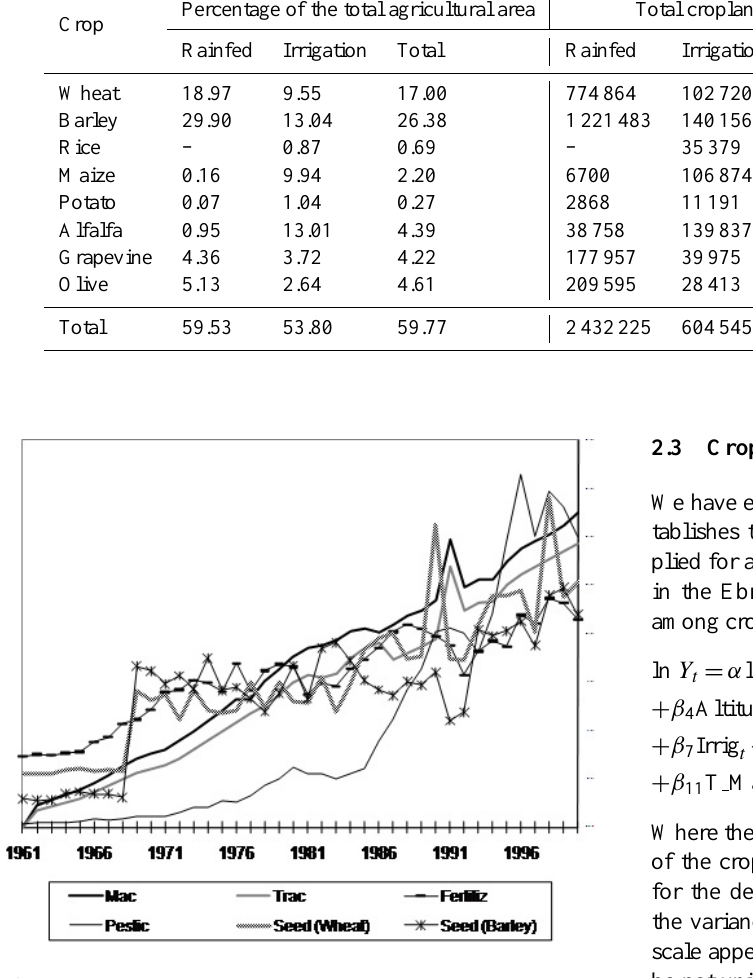
Fig. 2. Evolution of management indicators: farm equipment power (Mac), tractors (Trac), nitrogen fertilizer (Fert), pesticide con- sumption (Pest), or seeds improvement (Seed). Source: Quiroga, Iglesias,